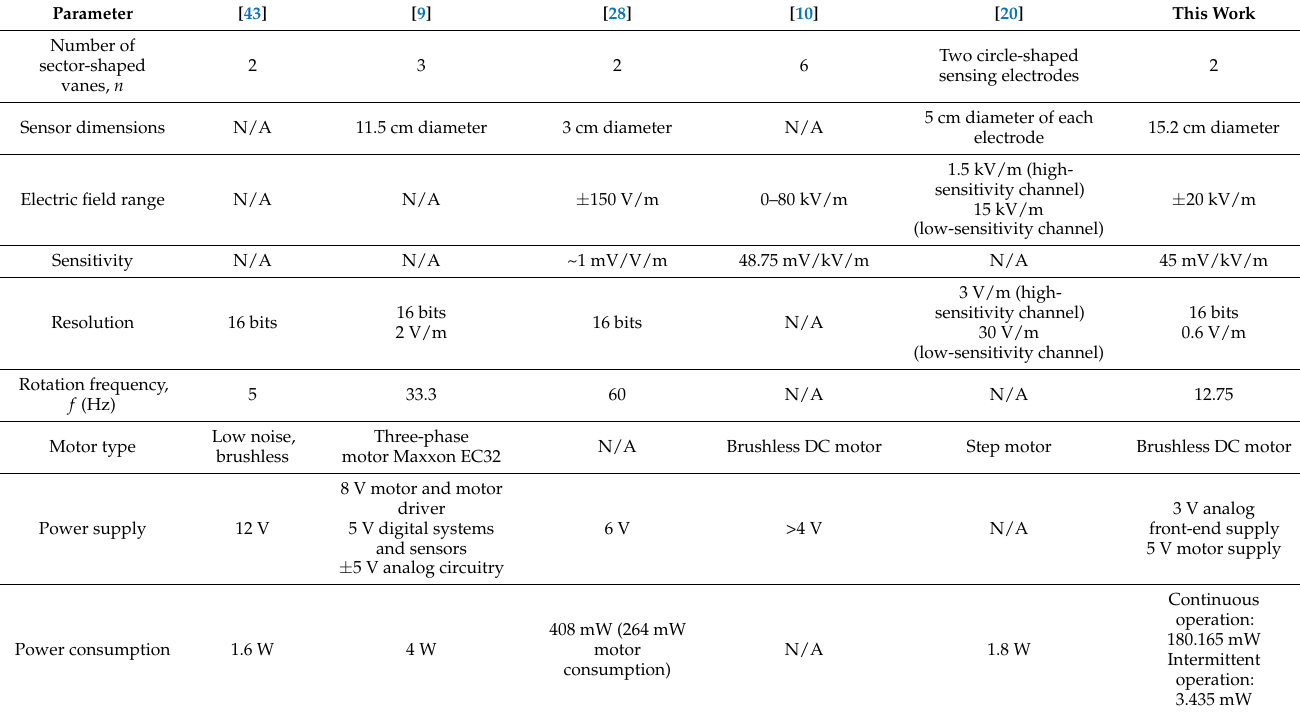
Table 6. Table of comparison of electric field mill sensor interface circuits in the